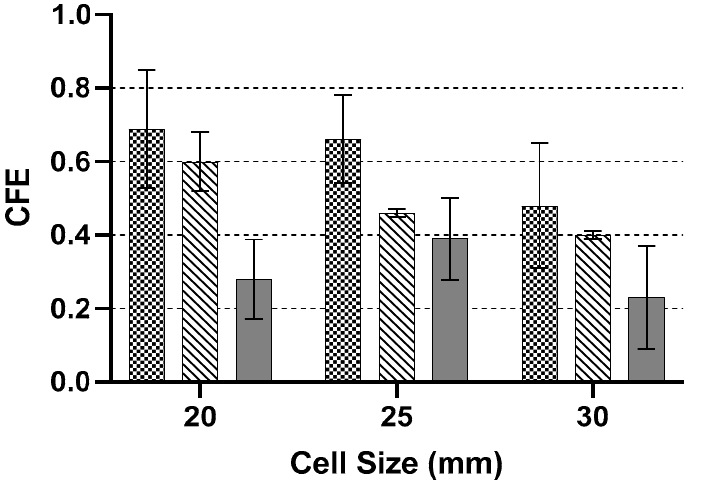
Figure 11. Comparison of CFE with different cell sizes and wall thickness.